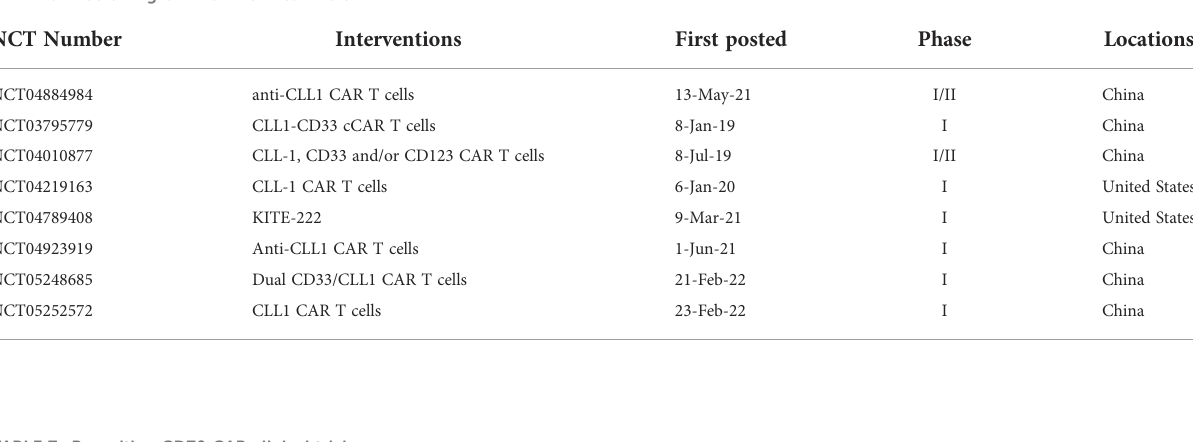
TABLE 6 Recruiting CLL1 CAR clinical trials.